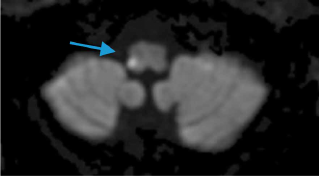
Figure 1: Diffusion weighted MRI demonstrating an area of restricted diffusion in the right posterior lateral medulla (arrow), consistent with an acute infarct.